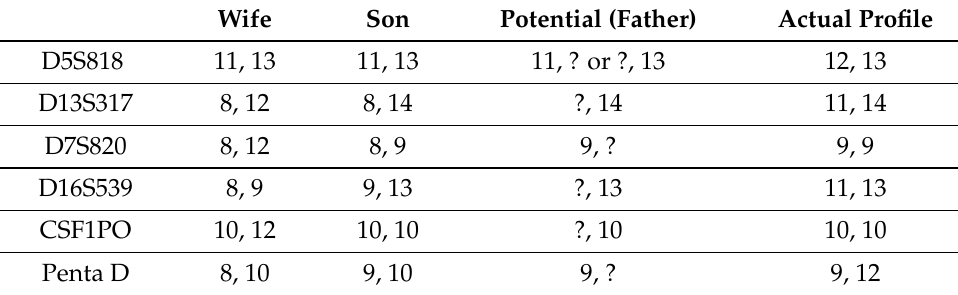
Table 2. Non-direct comparison (paternity